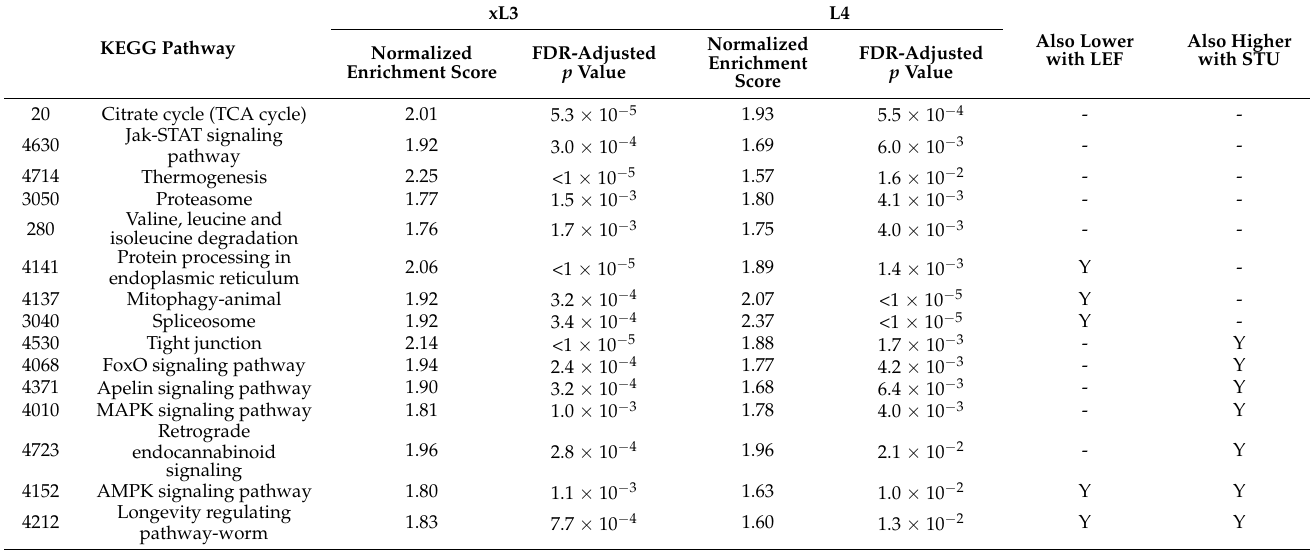
Figure 7. Principal components analysis (PCA) of RNA-seq datasets based on transcriptional profiles for xL3 and L4 H. contortus samples. Plots are shown for ( A ) principal components 1 and 2, and ( B ) principal components 2 and 3. Table 1. Top 15 KEGG pathways most significantly upregulated in both xL3 and L4 H. contortus in response to leflunomide